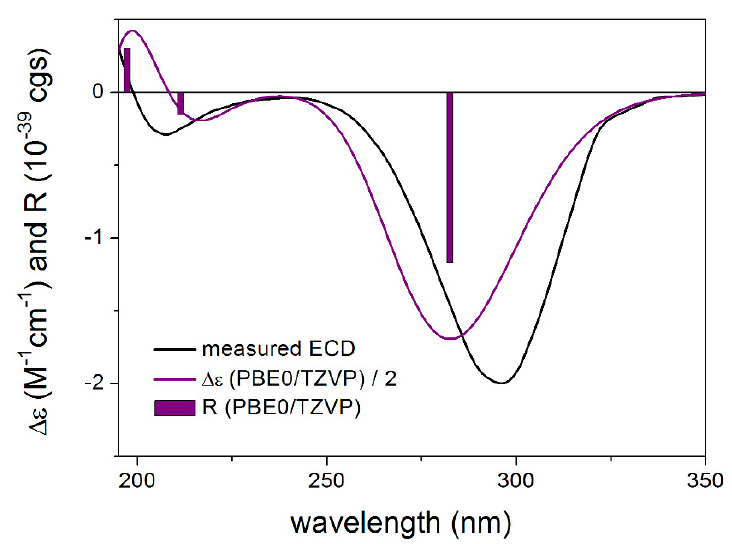
Figure 4. Experimental ECD spectrum of 3 in MeOH compared with the PBE0/TZVP PCM/MeOH ECD spectrum of the single low-energy CAM-B3LYP/TZVP PCM/MeOH conformer of proposed (1 S ,2 S ,4 S ,6 R ,8 R ,11 R )- 3 . Bars represent the rotational strength values.